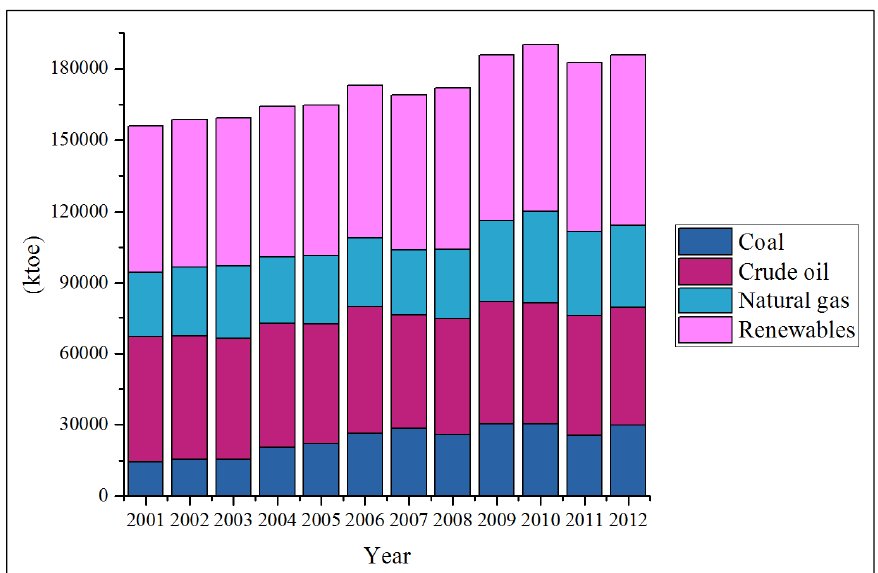
Figure 3. Indonesia: primary energy mix.